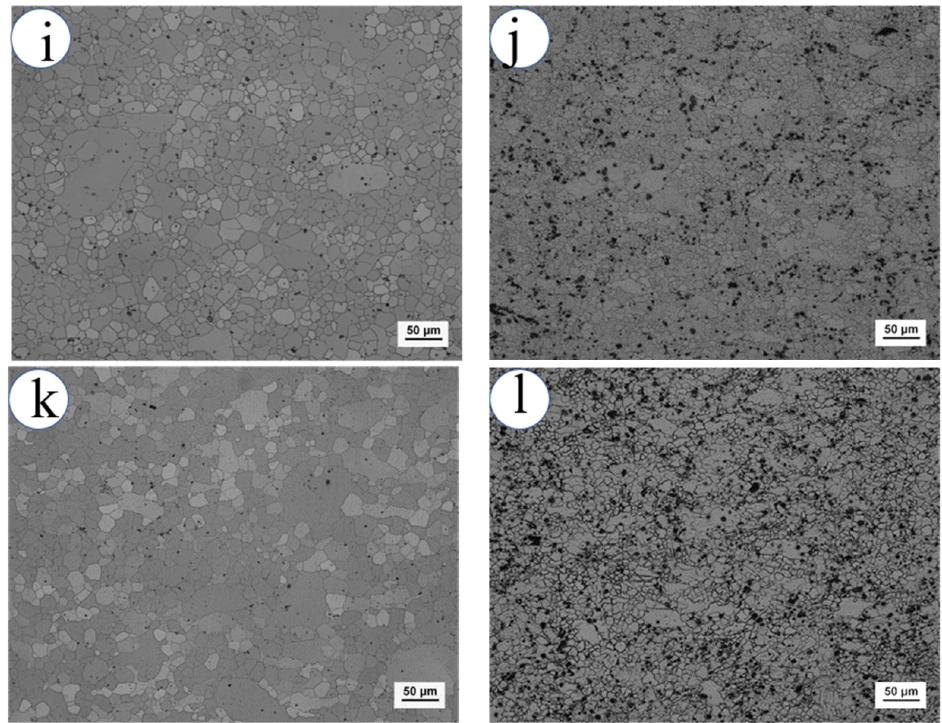
Figure 3. The microstructure of as-cast and ED surface of Mg-3Zn-0.2Ca alloy and 1 β -TCP/Mg-3Zn-0.2Ca composites: ( a ) A-as-cast, ( b ) C-as-cast, ( c ) A-as-extruded, ( d ) C-as-extruded, ( e ) A-2 P-593 K, ( f ) C-2 P-593 K, ( g ) A-4 P-593 K, ( h ) C-4 P-593 K, ( i ) A-6 P-593 K, ( j ) C-6 P-593 K, ( k ) A-8 P-593 K, ( l ) C-8 P-593 K.